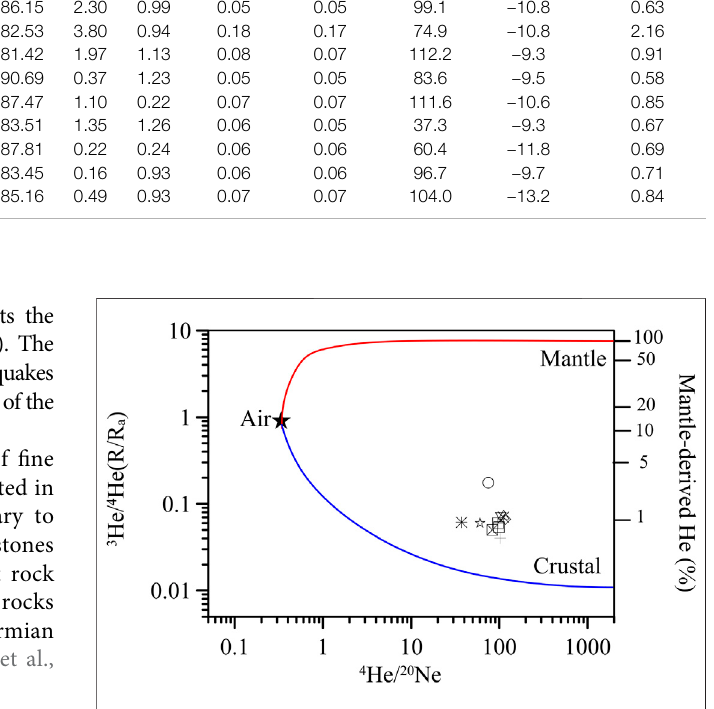
FIGURE 3 | Diagram of 4 He/ 20 Ne vs. 3 He/ 4 He (R/Ra) ratios. Mixing lines between the upper mantle and atmosphere ， and the crust and atmosphere were calculated using the end members:upper mantle ( 4 He/ 20 Ne (cid:1) 100,000, 3 He/ 4 He (cid:1) 12 × 10 – 6 ) (Graham 2002), air ( 4 He/ 20 Ne (cid:1) 0.318, 3 He/ 4 He (cid:1) 1.4 × 10 – 6 ) (Ozima and Podosek, 1983), continental crust